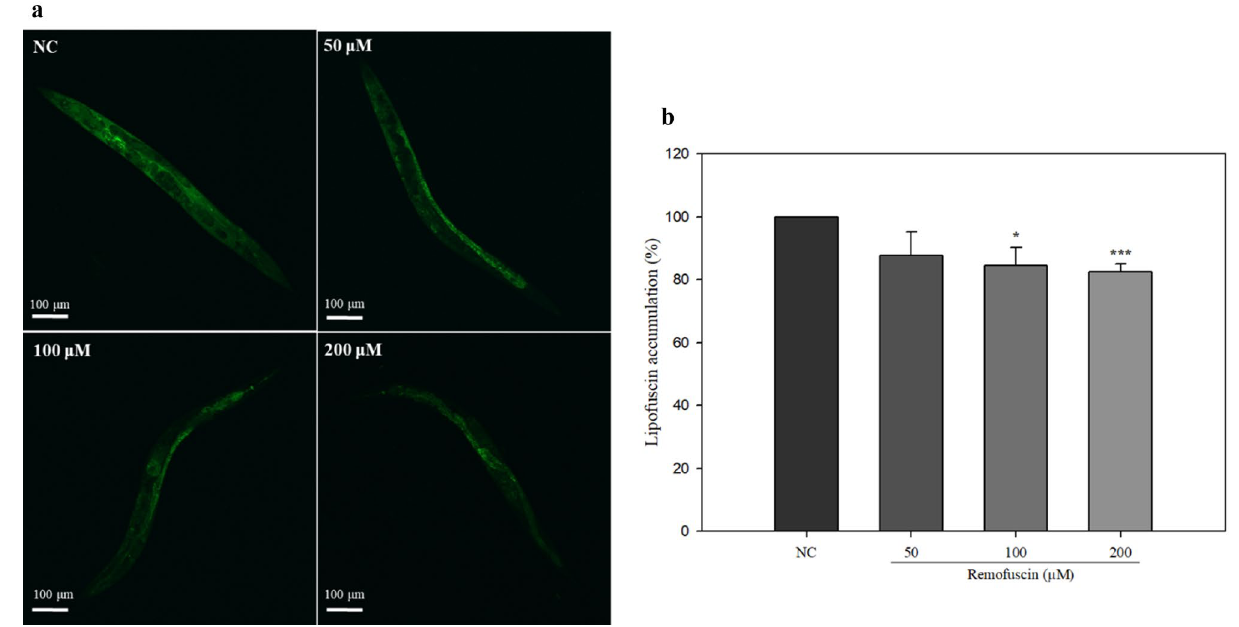
Figure 2. Accumulation of lipofuscin in remofuscin-treated C. elegans (N2). ( A ) Images of lipofuscin fluorescence in worms treated with various concentrations of remofuscin on day 14 (scale bar = 100 µm). ( B ) The lipofuscin fluorescence in the worms was quantified using ImageJ software. Ten worms from each group were used for the measurements. All experiments were conducted three times